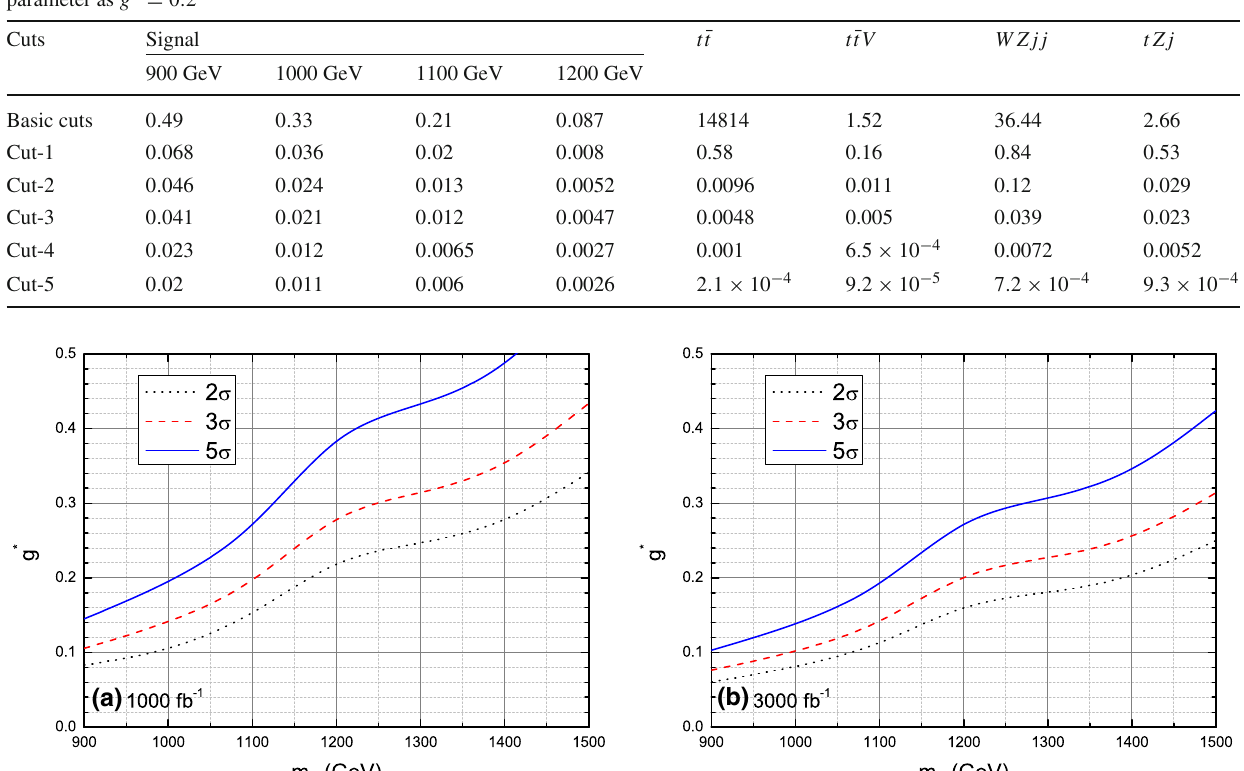
Table 2 The cut flow of the cross sections (in fb) for four typical signals and the relevant backgrounds at the 14 TeV LHC. Here we take the parameter as g ∗ = 0 . 2